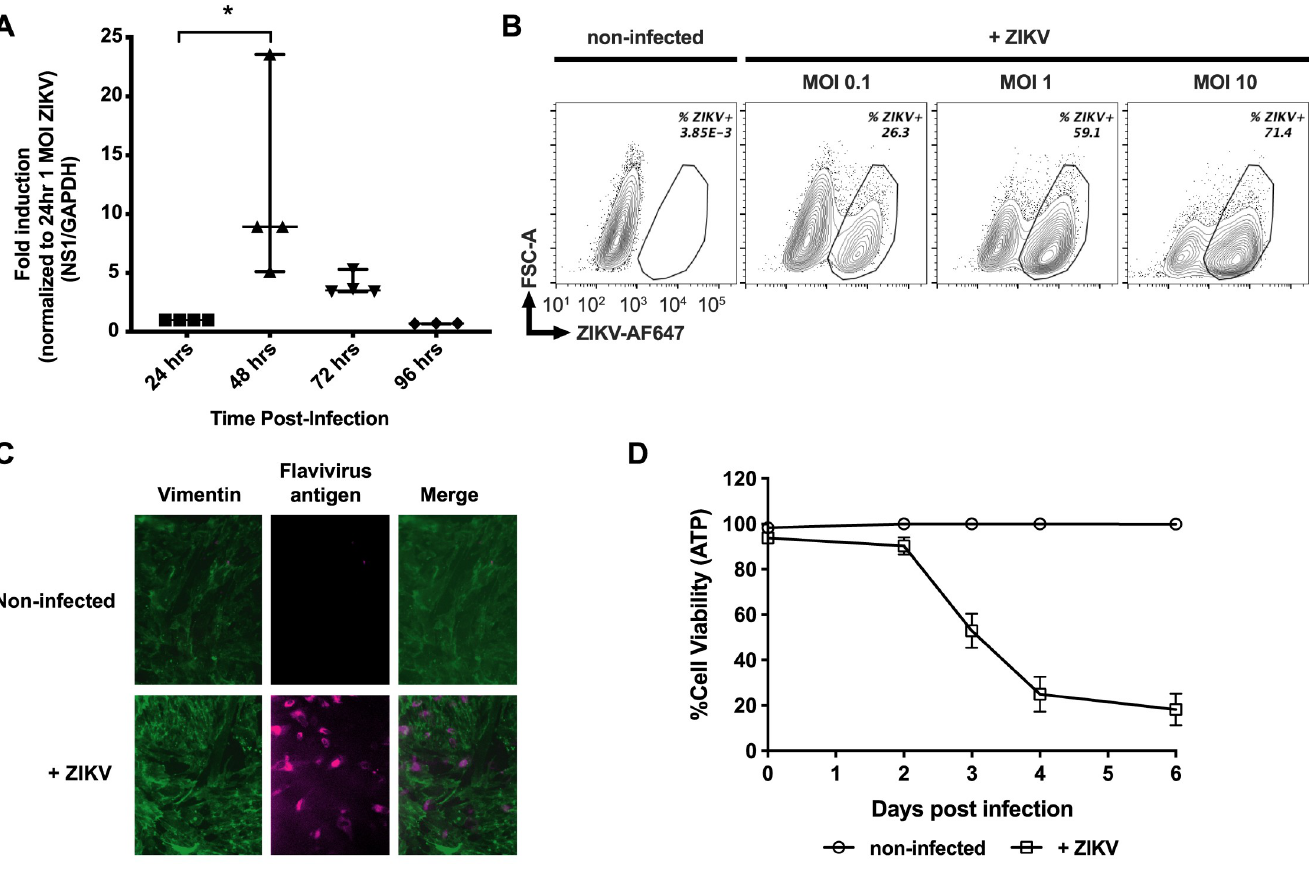
Fig 1. ZIKA virus infects and kills fetal cardiac progenitor cells. fcMSCs (n = 4) were infected with 1 MOI of ZIKV for 6 h. (A) fcMSCs were assessed for NS1 mRNA levels 24, 48, 72 and 96 h post-infection using qRT-PCR. Median values are plotted with 95% CI. (B) Intracellular staining for ZIKV detection was performed with anti-flavivirus group antigen 4G2 antibody 48 h post-infection, as described in Materials and Methods. Representative image shown. For flow cytometry data acquisition, aqua live/dead stained cells were first gated for their size (FSC vs SSC) and then the percentage of ZIKV infected live cells was determined using 4G2 antibody. (C) Immunofluorescence staining for group antigen 4G2 was performed at 48 h post-infection using confocal microscopy. (D) ZIKV-infected fcMSCs (n = 4 donors) and their matched non-infected controls were pre-treated as indicated and cell viability was assessed using the CellTiter-Glo Luminescent Cell Viability Assay, which determines cell viability based on quantification of intracellular